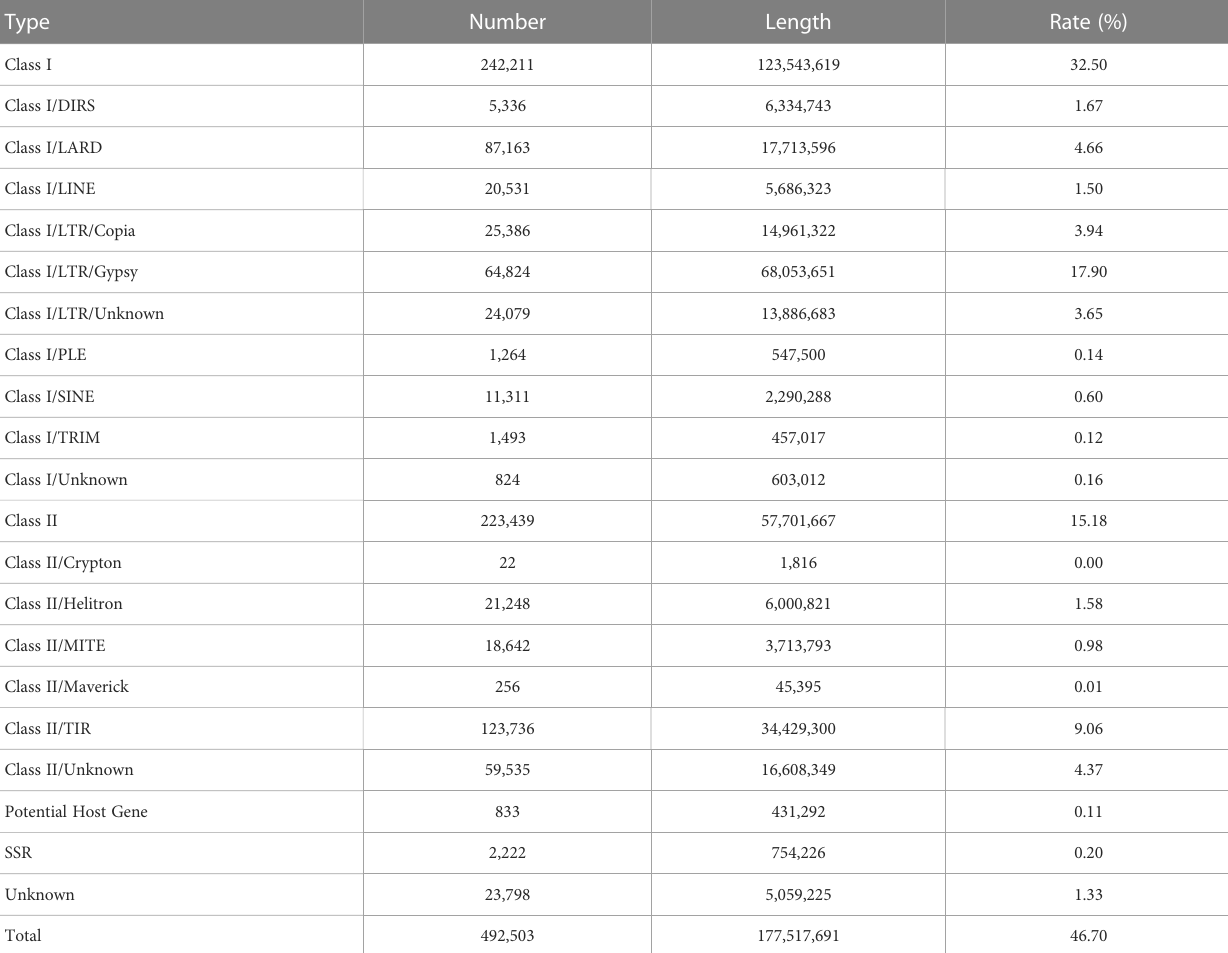
TABLE 3 The statistics information of repeat regions in QG10